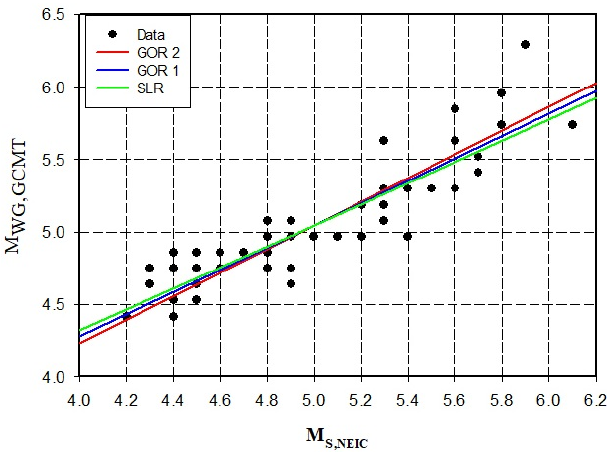
Figure 5. The (M S,NEIC − M wg ) data, as well as the GOR1, GOR2, and SLR regression lines.